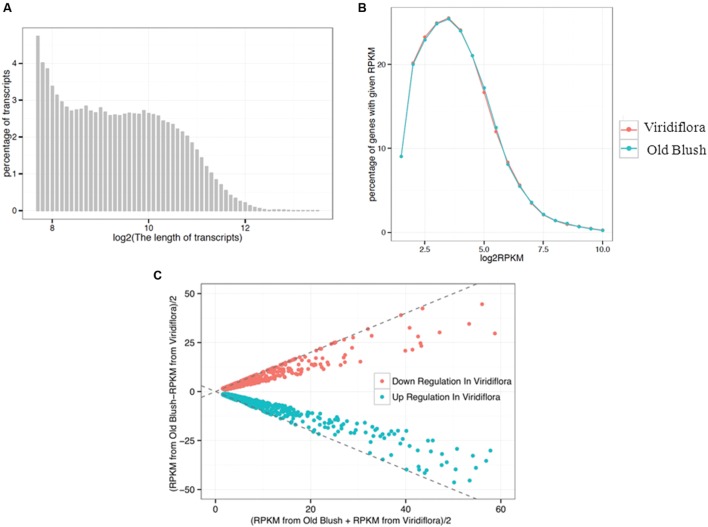
Sequence length distribution of assembled transcripts (A), plotting distribution of log-transformed FPKM (Fragments per kilobase of exon per million fragments mapped) values (B) and MA-plot for differential expressed genes (C).
(A) Displays the distribution of transcripts length range. (B) Shows the percentage of genes with a given FPKM value. (C) Shows the differential expressed genes. The X-axis indicates the value of [FPKM from Old Blush + FPKM from Viridiflora]/2, and the Y-axis indicates the value of [FPKM from Old Blush – FPKM from Viridiflora]/2.